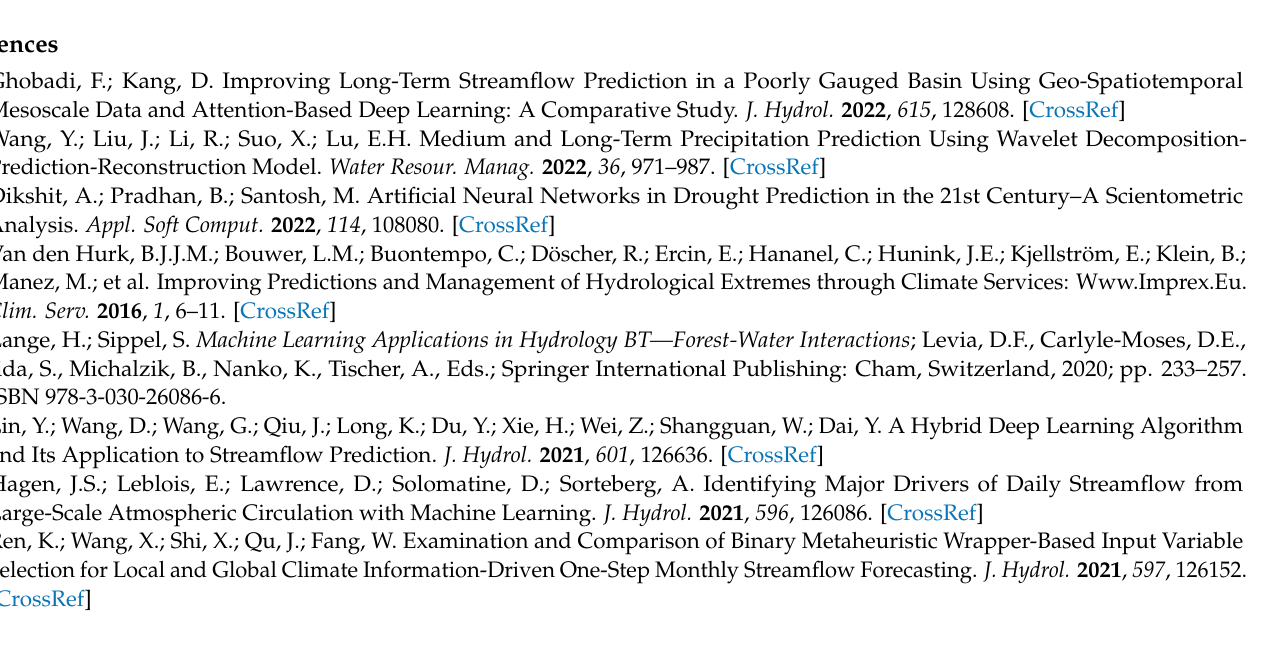
Table S1: General structures of deep neural